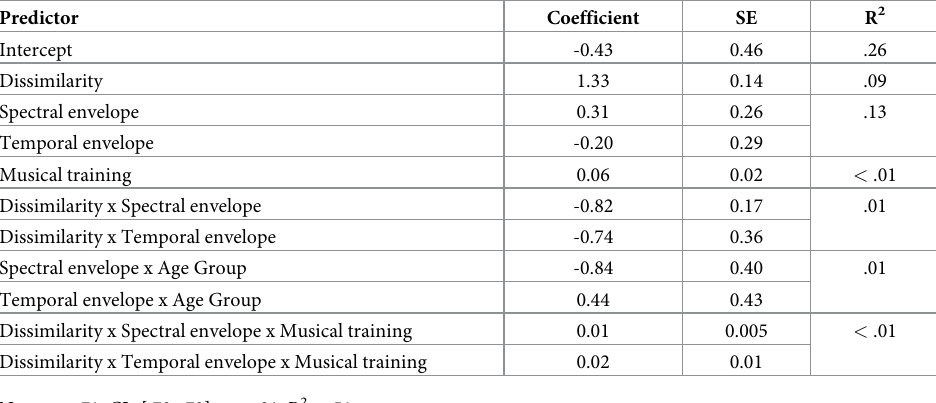
Table 6. Summary of mixed effects multiple linear regression model with common perceptual scale. Coefficients for each predictor (and each level, as relevant) along with standard error (SE) and predictor R 2 are reported along with Pearson’s correlation, 95% CIs, p-value and R 2 for full models in the note